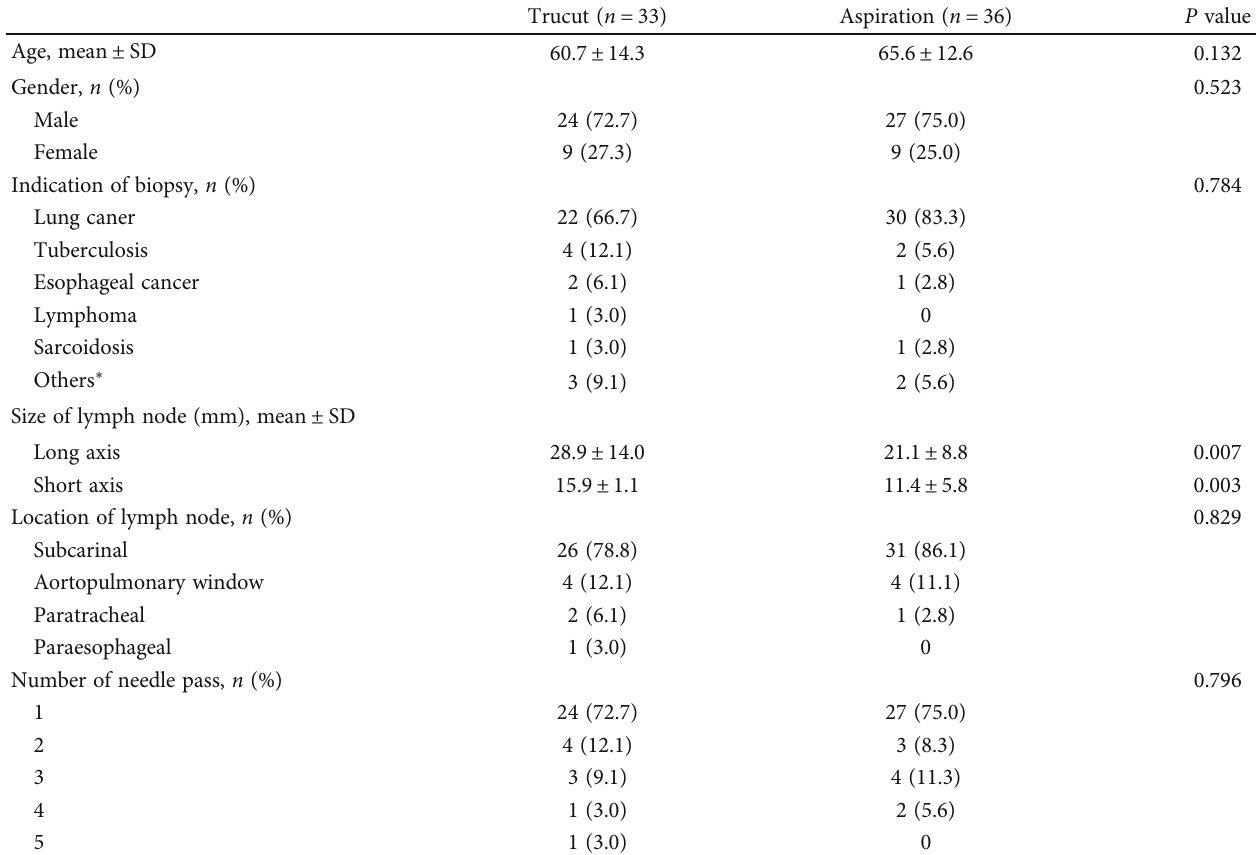
Table 2: Characteristics by needle